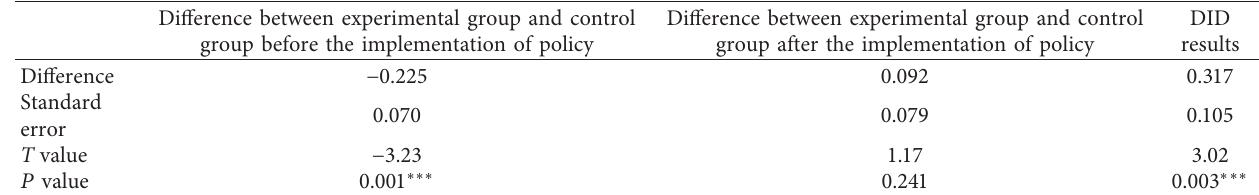
Table 3: The assessment based on PSM-DID method. Difference between experimental group and control Difference between experimental group and control group before the implementation of policy group after the implementation of policy